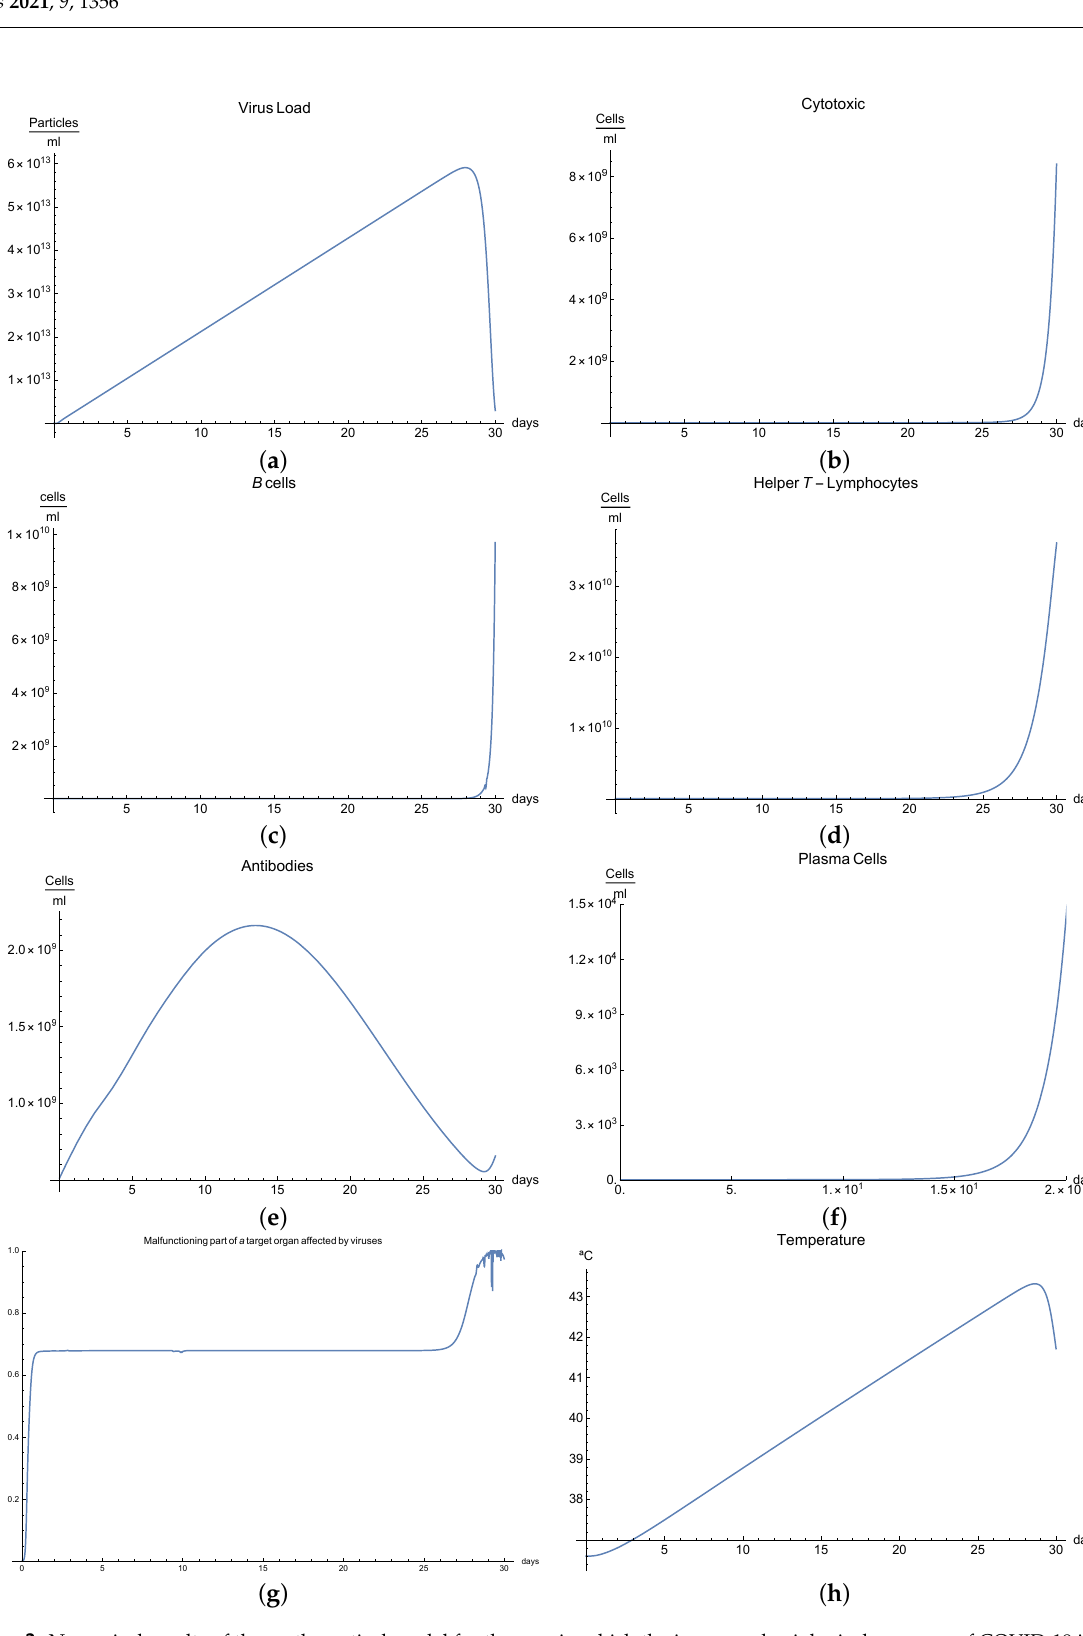
Figure 3. Numerical results of the mathematical model for the case in which the immunophysiological response of COVID-19 infection in its “acute” form: ( a ) the viral load V ( t ) , ( b ) the cytotoxic T-lymphocytes T e ( t ) , ( c ) the B-lymphocytes B ( t ) , ( d ) the class 1 helper T-lymphocytes T H 1 ( t ) , ( e ) the antibodies A ( t ) , ( f ) the plasma cells P ( t ) , ( g ) the malfunctioning part of a target organ affected by viruses m ( t ) , and ( h ) body temperature θ ( t ) . In all cases, the numerical results are simulated for the “acute”